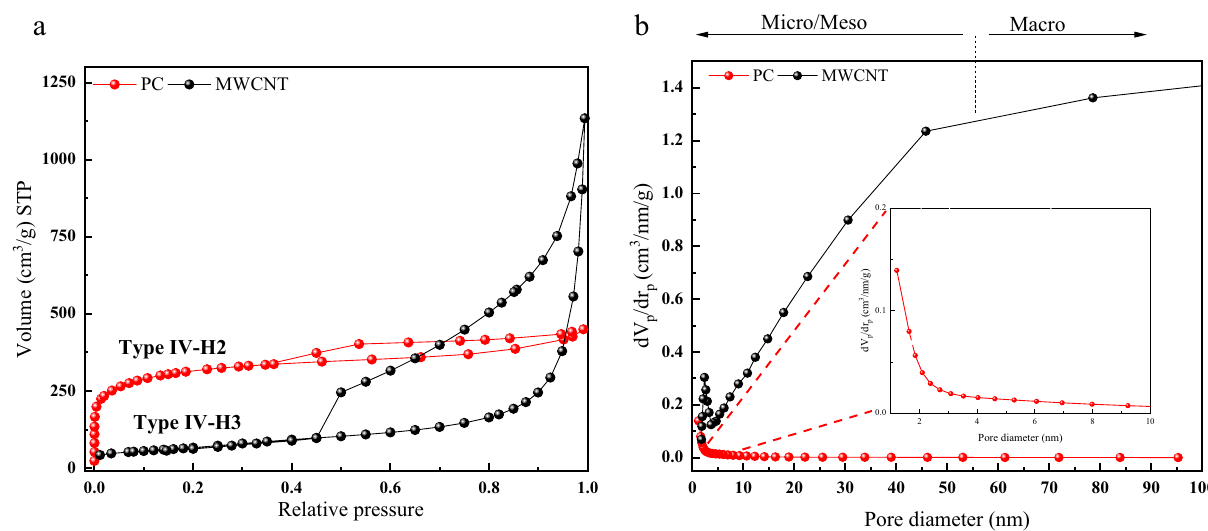
Figure 2. Nitrogen sorption/desorption isotherms at 77 K ( a ) and BJH pore size distribution profiles (inset is belonged to porous carbon) ( b ) of the porous carbon and